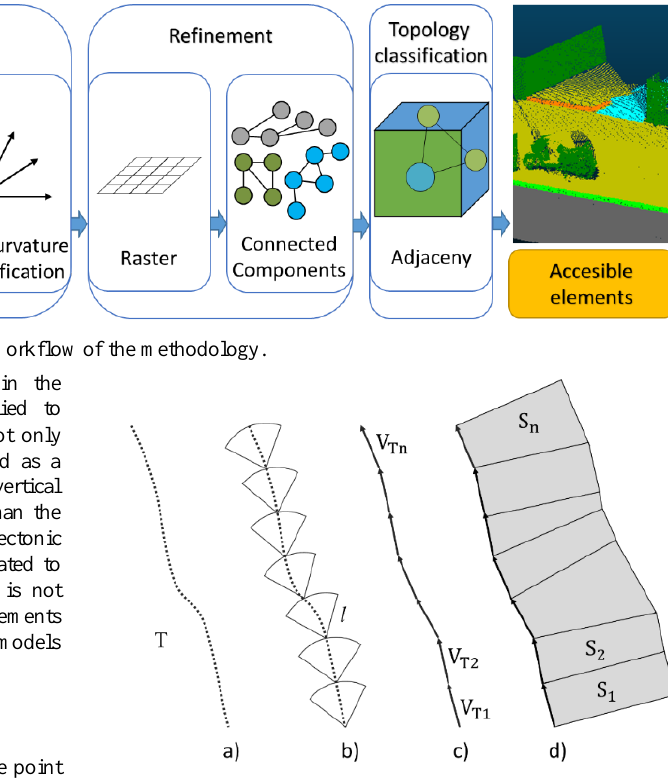
Figure 2. Trajectory segmentation: a) point line of MLS trajectory, b) radius search along trajectory, c) stretch vectors, d) point cloud in stretches.